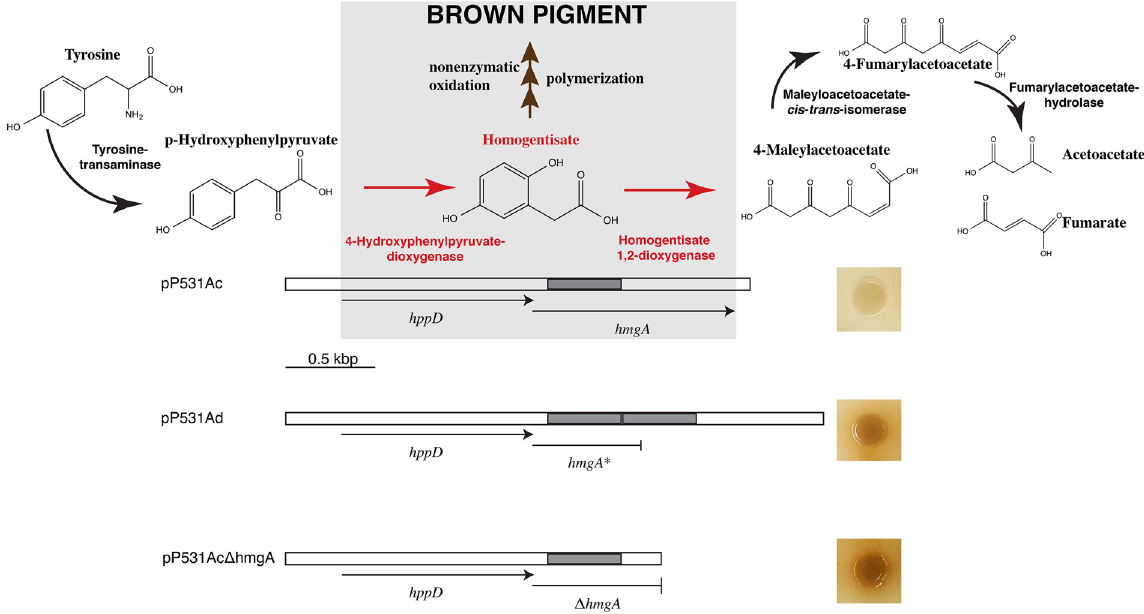
Figure 3. Pathway for tyrosine metabolism and production of the brown pigment. The top portion of the figure shows the tyrosine catabolic pathway and the key enzymes for formation of the brown pigment are shown within the gray box. The box also includes the region of DNA that includes the hppD and hmgA genes. The lower portion of the figure shows diagrams of the fragments and genes included in all three recombinant plasmids. The grayed region is directly repeated in the 531Ad strain; hmgA * indicates that the 410-bp tandem duplication (highlighted in gray) in this gene produces a sequence that codes for a truncated homogentisate 1,2-dioxygenase (Supplementary Fig. S2). The phenotypes produced by each recombinant plasmid in E . coli cultured in LB agar are shown to the right of the genetic